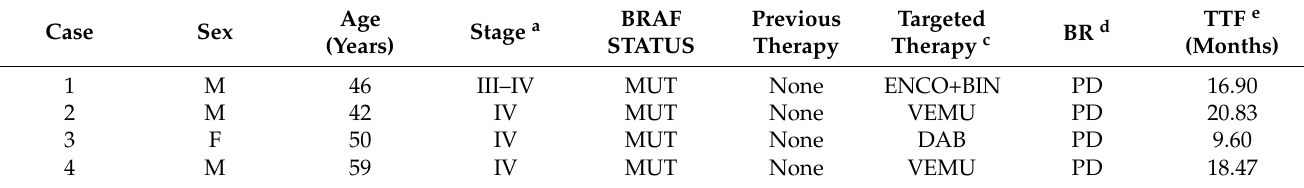
Table 2. Demographic and clinical characteristics of melanoma